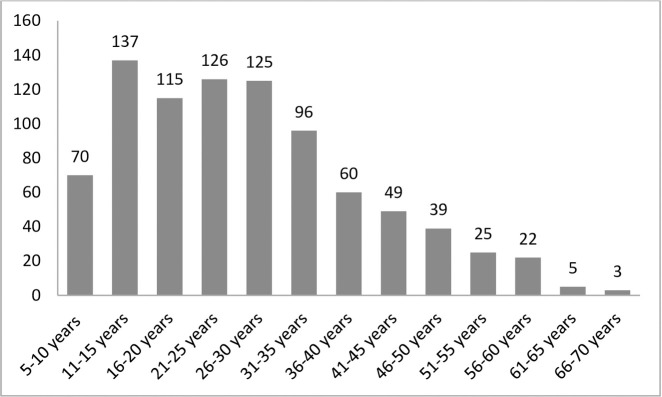
Age distribution.